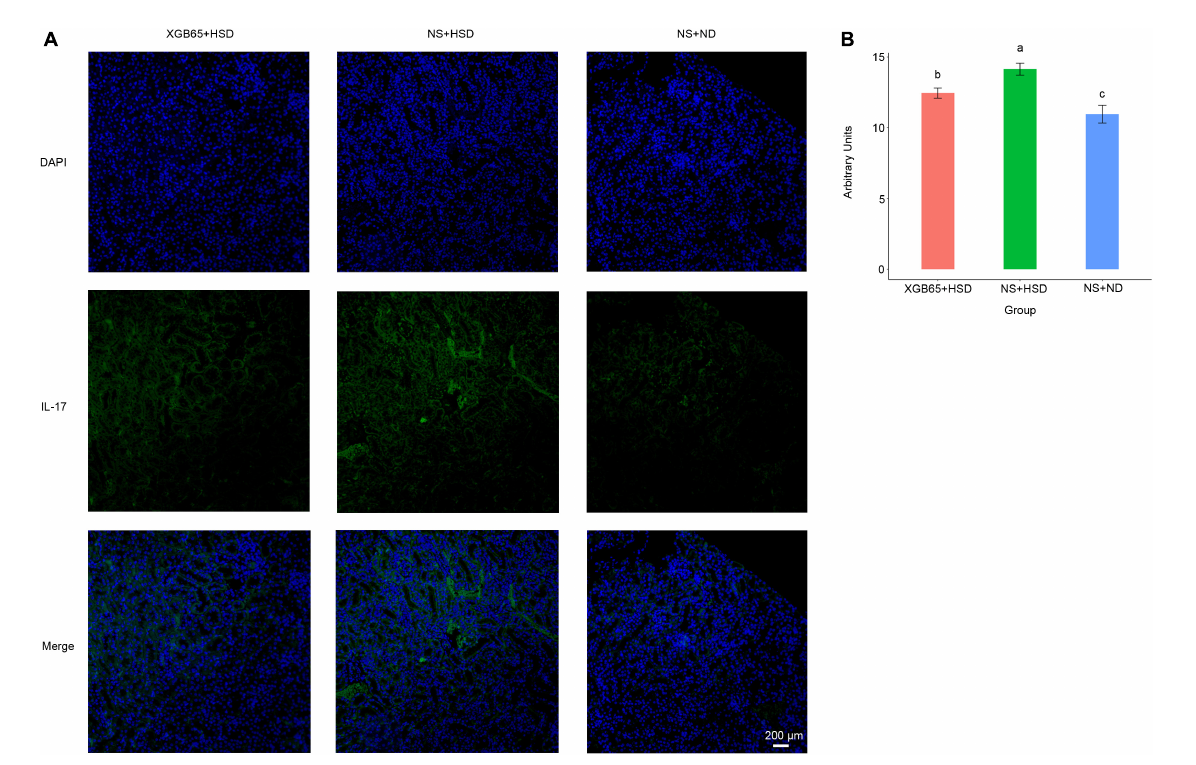
FIGURE6 Parabacteroides strain XGB65 restores renal IL-17A. (A) IL-17A immunofluorescence in kidney sections in the XGB65 + HSD, NS + HSD, and NS + ND groups (scale bars = 200 µ m). (B) Mean fluorescence intensity of IL-17A was significantly increased in the NS + HSD group compared to the NS + ND group, while it was significantly decreased in the XGB65 + HSD group compared to the NS + HSD